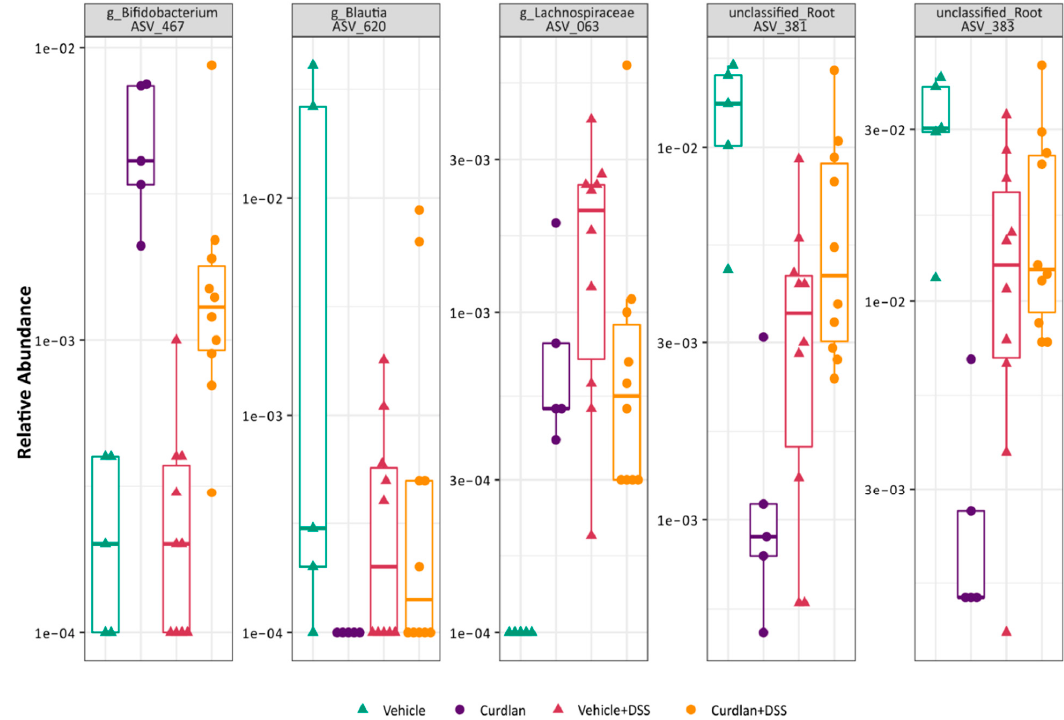
Figure 4. Abundance of bacterial taxa affected by curdlan. Phylogenetic diversity matrices are plotted for the observed species for vehicle (green), curdlan (purple), vehicle+DSS (pink) and curdlan+DSS (orange). Individual samples are represented as symbols. Statistical differences were tested through Wilcoxon methods, where p < 0.05 was considered to be significant.